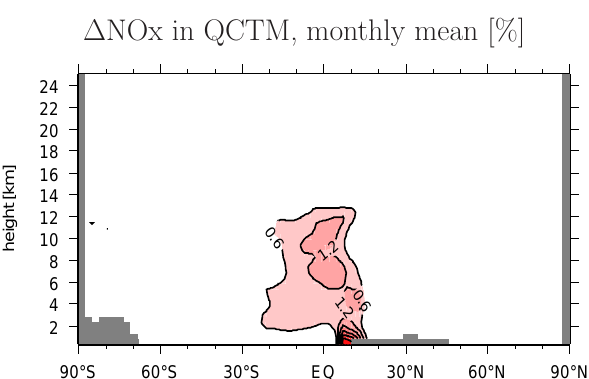
Fig. 5. Same as Fig. 4c, but for NO x . Isoline intervals are